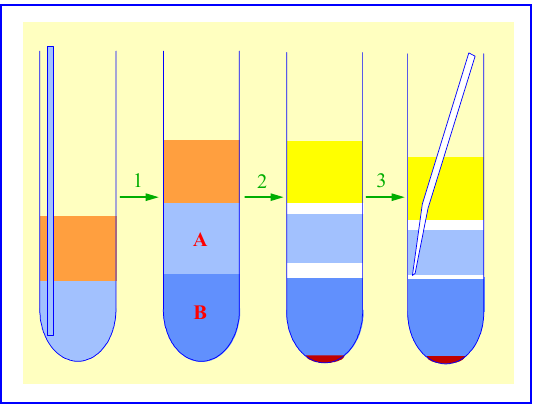
FIGURE 2 . Separation of PMNs from mononuclear cells from an LRP. (1) LRP layered over A (1.077 g/ml) and B (1.090 or 1.095 g/ml). (2-3) After centrifugation, PMNs harvested from lower